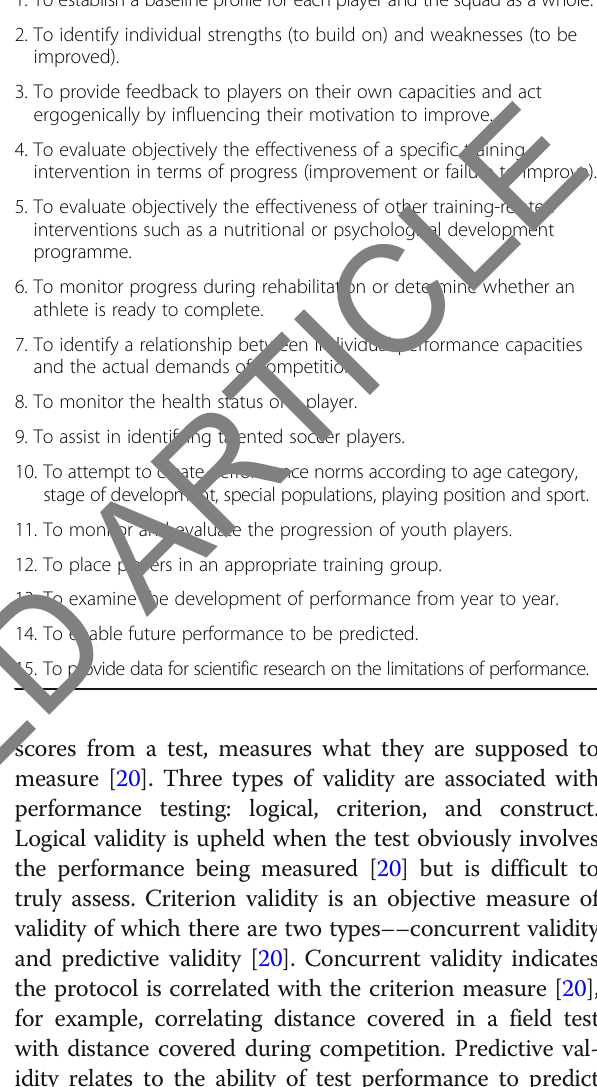
Table 1 Reasons for fitness assessment in soccer (according to Carling